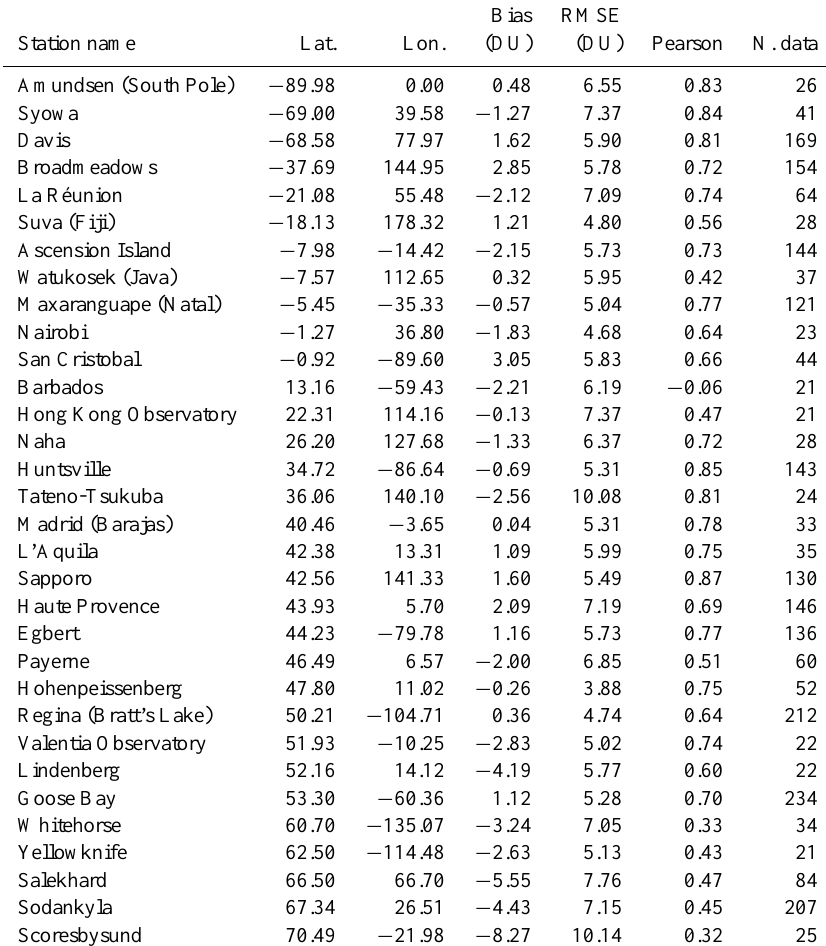
Table 5. Results for the NN trained without OMI reflectances, divided by station, sorted by increasing latitude. Only stations with at least 20 measurements included in the D test set were considered.